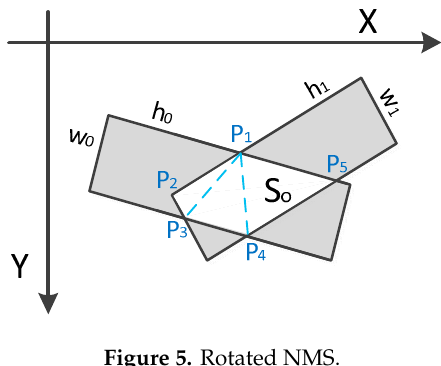
Figure 4. Rotated bounding box regression.